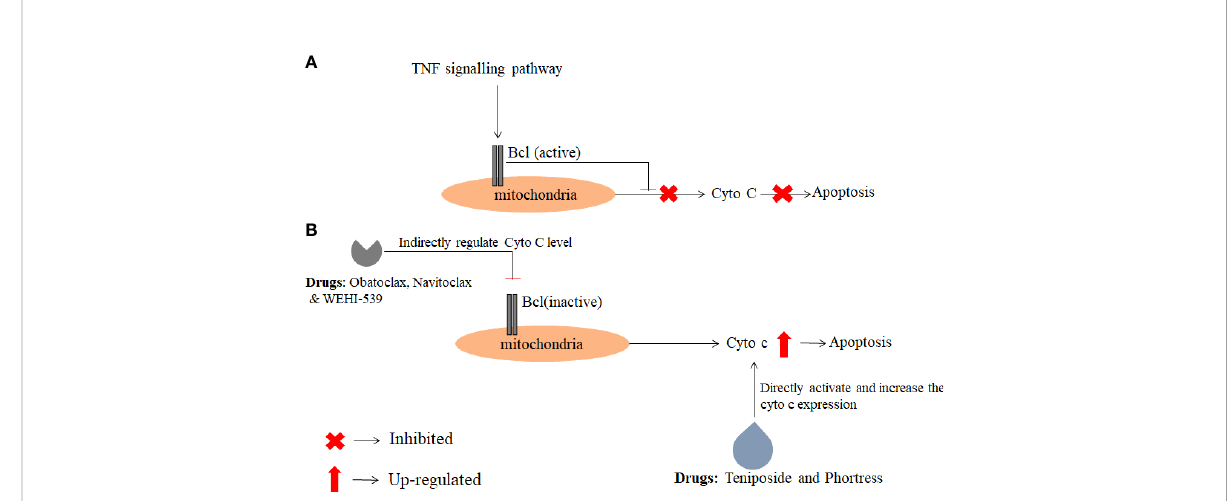
FIGURE 6 The fi gure depicts the action mechanism of anti-cancer drugs which regulate directly or indirectly Cyto C expression. The data were obtained from the PubChem database and a pathway was analyzed using KEGG pathway analysis. (A) Describes the inhibition of Cyto C expression in cancer conditions (B) Activation of Cyto C by anti-cancer